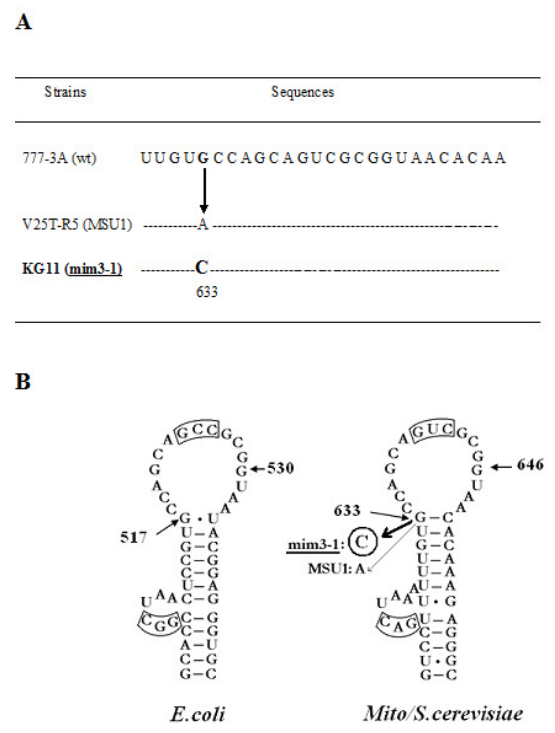
FIGURE 3: (A) Nucleotide sequence of the mim3-1 region in the 15S rRNA. The nucleotide sequence of 629-754 region in the mitochondrial 15S rRNA of various strains is shown.